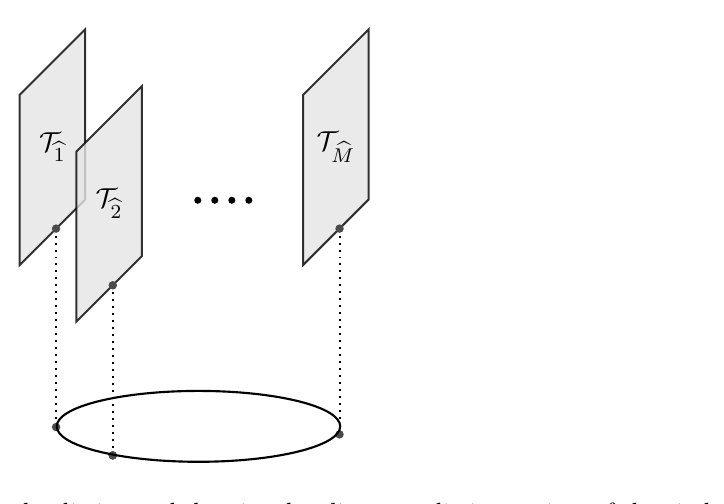
Figure 5 . The sheets represent the distinct subtheories that live over distinct points of the